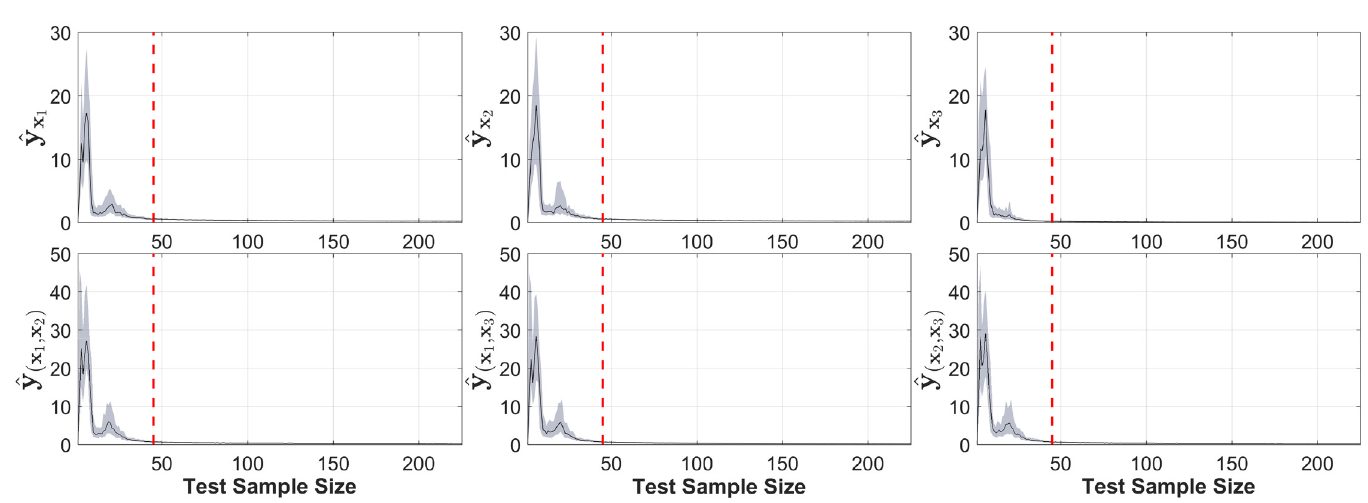
Fig 9. Convergence of the error between the real functional form and the estimated output provided by NObSP for different test set sizes. The solid line represents the median value and the shade area represents the 25 and 75 percentiles of the error. For each test set size 100 random simulations were performed. The red dashed line indicates the maximum rank obtained for the kernel matrices during training, which in this particular case was